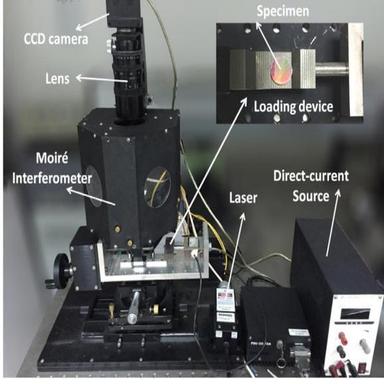
Experimental setup.